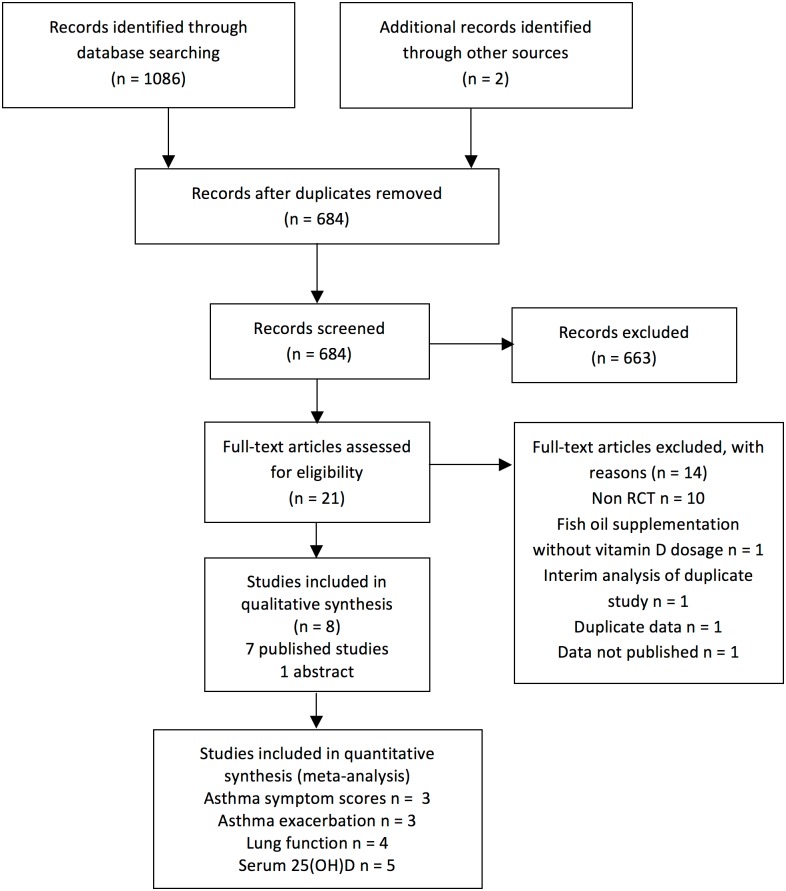
PRISMA flowchart.